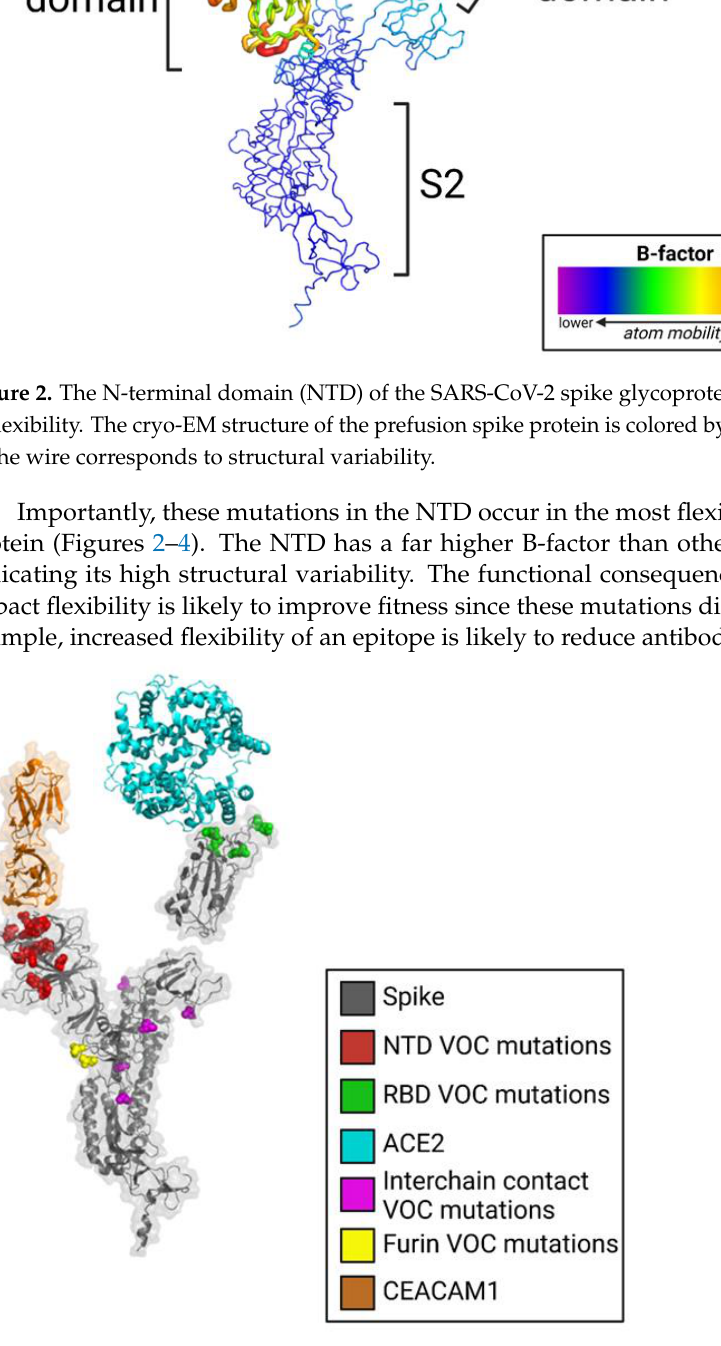
Figure 3. Mutations in the N-terminal domain (NTD) cluster in a manner that likely modulates binding interactions. The spike glycoprotein is shown in gray with mutations present in variants of concern (VOC) shown in red, NTD VOC mutations in red, RBD VOC mutations in green, interchain contact VOC mutations in magenta, furin cleavage site mutations shown in yellow, ACE2 shown in cyan, CEACAM1 shown in orange.